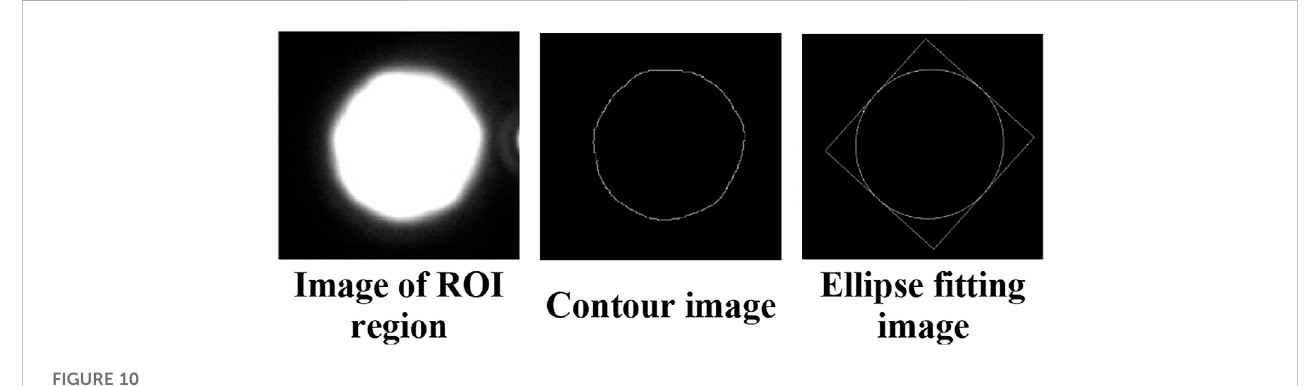
FIGURE 10 ROI area ellipse detection.